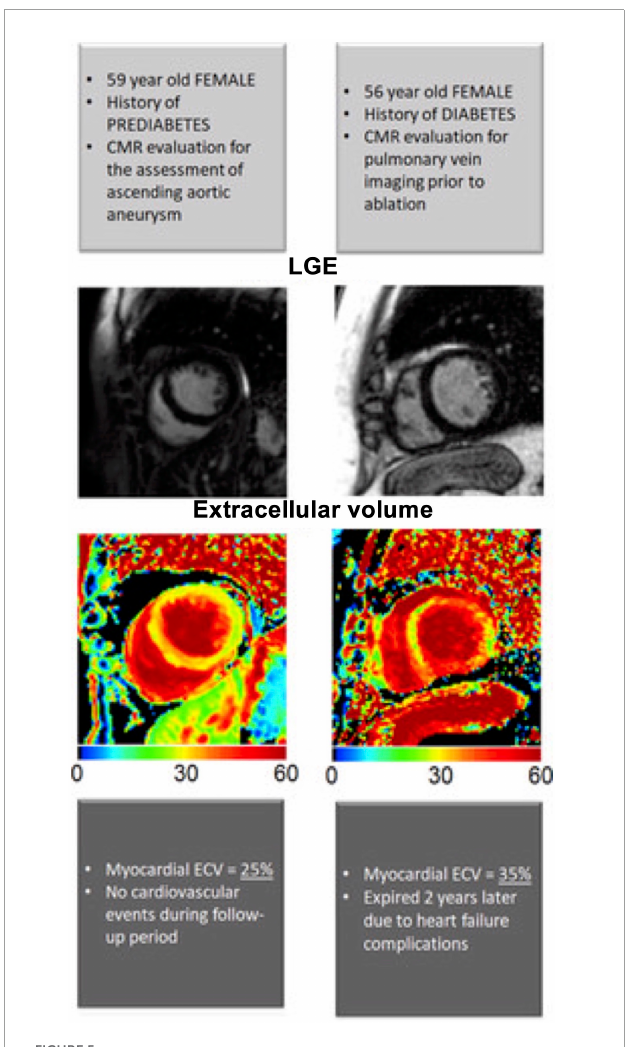
FIGURE5 Late gadolinium enhancement images and extracellular volume fraction (ECV) maps by diabetic status. Example of two patients, with prediabetes and diabetes mellitus. Both patients had no late gadolinium enhancement (indicative of replacement fibrosis). The patient with diabetes mellitus had significantly higher amount of ECV (indicative of interstitial fibrosis) compared to the patient without diabetes mellitus. CMR indicates cardiac magnetic resonance. Adapted from Khan et al. with permission